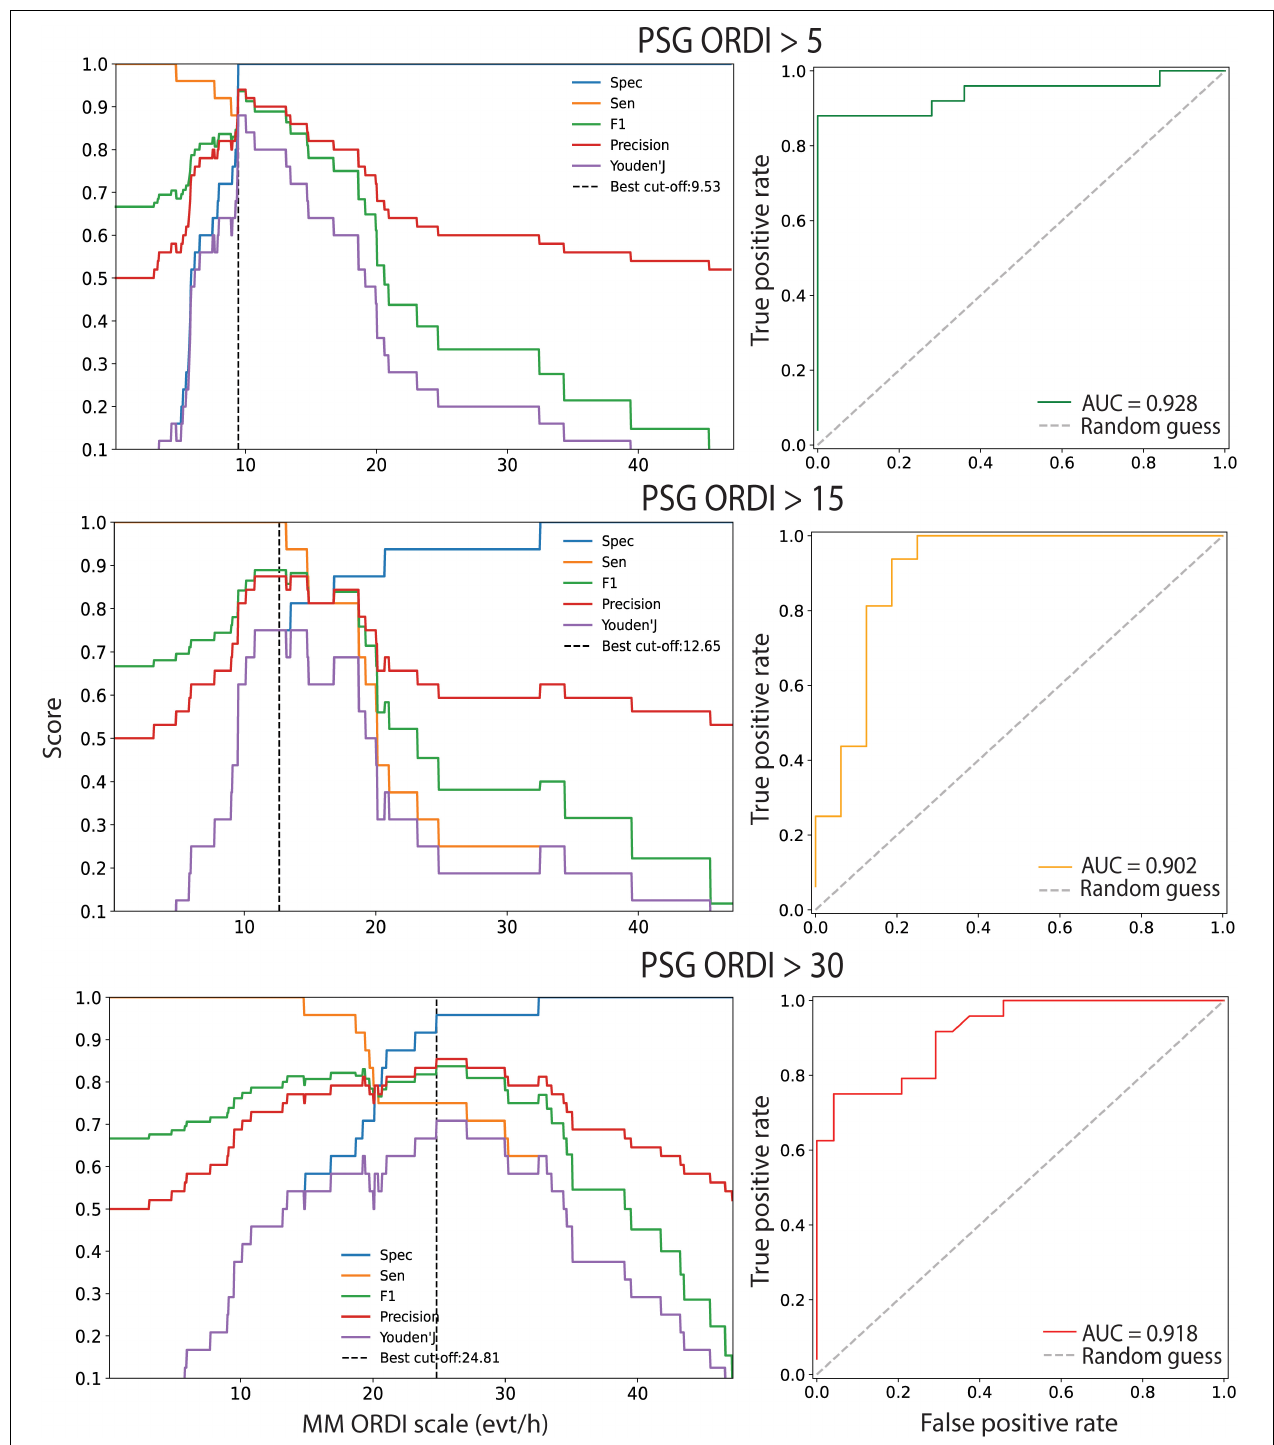
FIGURE 3 | ROC curve analysis for MM-ORDI versus average PSG-ORDI. Cut-off calibration and ROC curves evaluating the global performance of 3 binary classification rules to detect patients with OSA with polysomnography-derived respiratory disturbance index (PSG-ORDI) of at least 5, 15 or 30 events/hour, using MM-ORDI. The 95% CIs of the area under the curve (AUC) were obtained by bootstrapping. The diagonal dotted line serves as a reference and shows the performance if OSA detection was made randomly. ROC: receiver operator characteristic; MM: mandibular movements; ORDI: obstructive respiratory disturbance index; OSA: obstructive sleep apnoea; 95% CIs: 95% confidence intervals; AUC: area under the